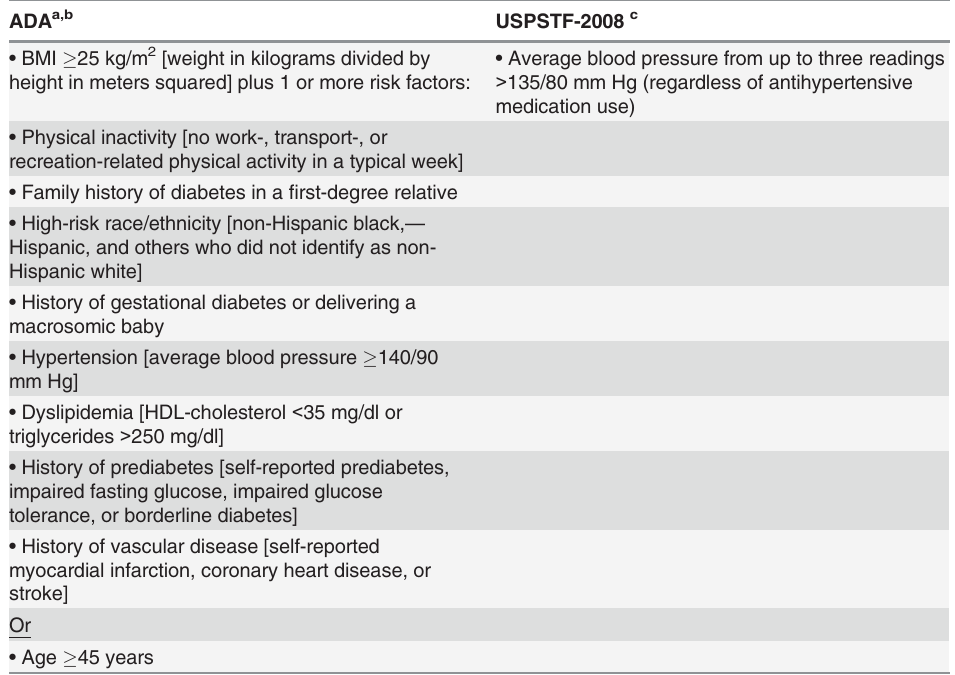
Table 1. Criteria for three screening guidelines and definitions from the National Health and Nutrition Examination Survey, 2007 –